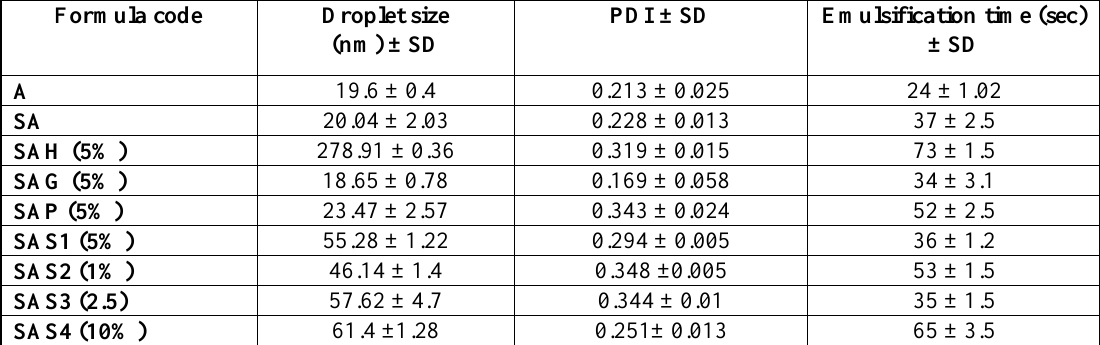
Table 2.Characterization of supersaturable formulation and comparison to conventional liquid selfnanoemulsion formula.